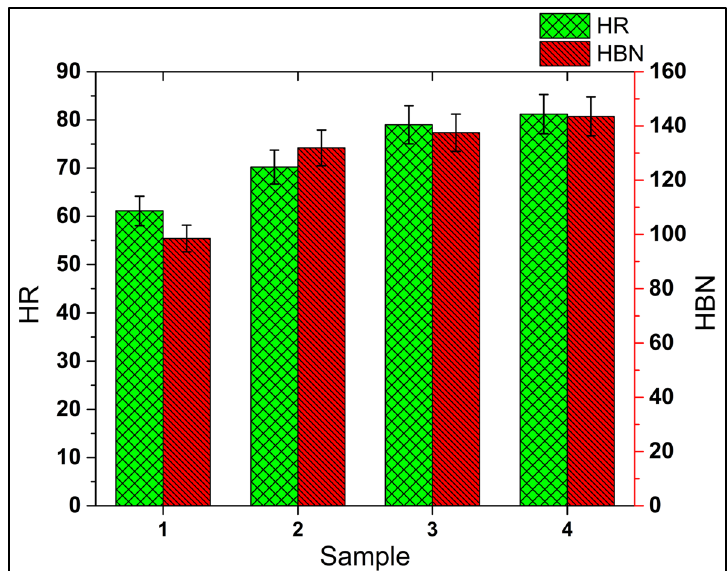
Figure 11. Hardness of: AA7075 (base alloy, sample 1), AA7075-5wt %SiC (MMC, sample 2), AA7075-5wt %SiC-3wt %RHA (s-HMMC, sample 3) and AA7075-5wt %SiC-3wt %RHA-1wt %CES (n-HMMC, sample 4).